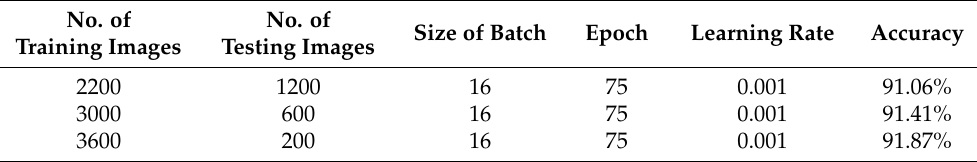
Table 4. Accuracy comparison between training and testing images.